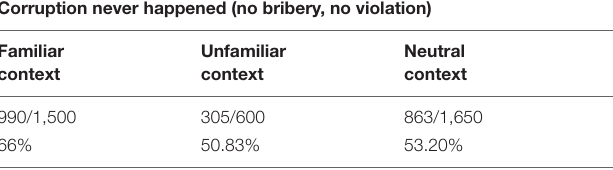
Table 6 | Proportion of pairs never commit any unethical decision.